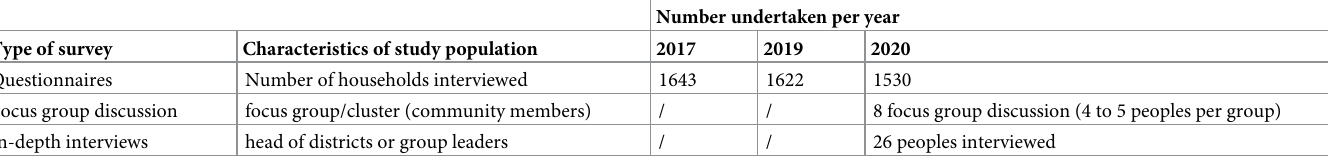
Table 1. Surveys conducted to assess population knowledge and